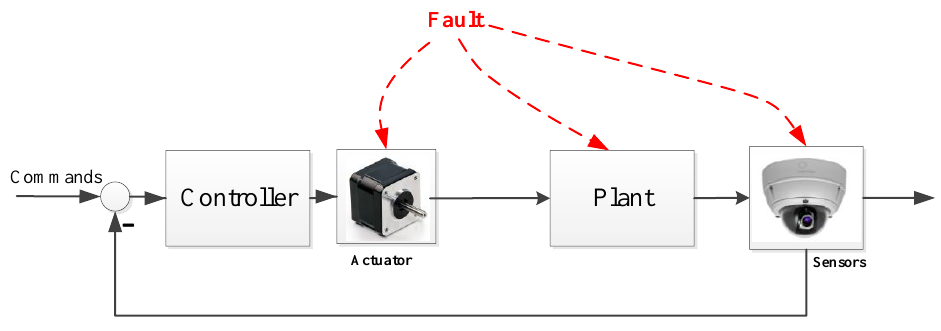
Figure 1. Potential faults in a control